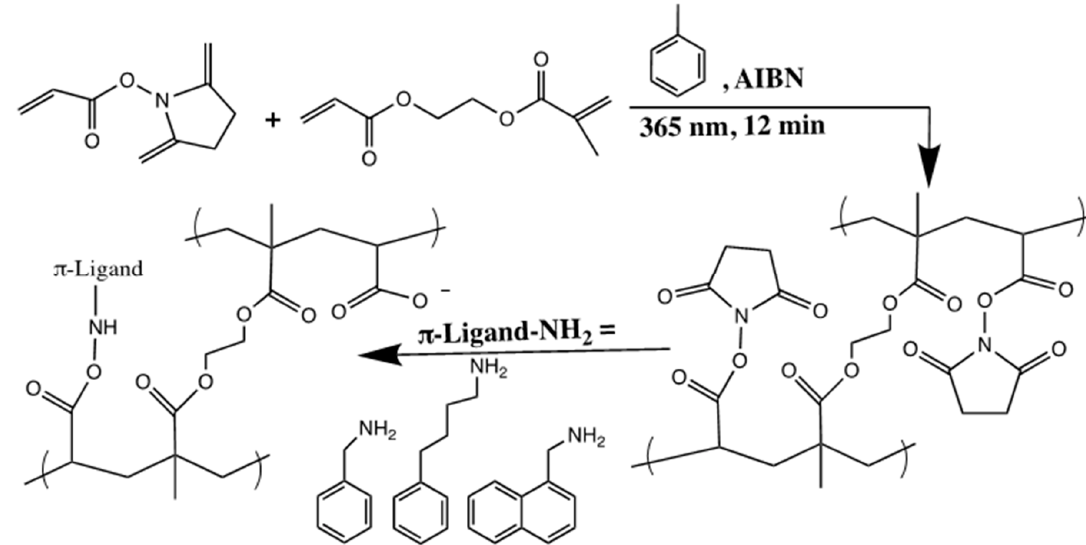
Scheme 17. Schematic representation of the two-step synthetic pathway applied to prepare poly( N - acryloxysuccinimide (NAS)- co -EDMA) monolith functionalized with varied aromatic selectors: